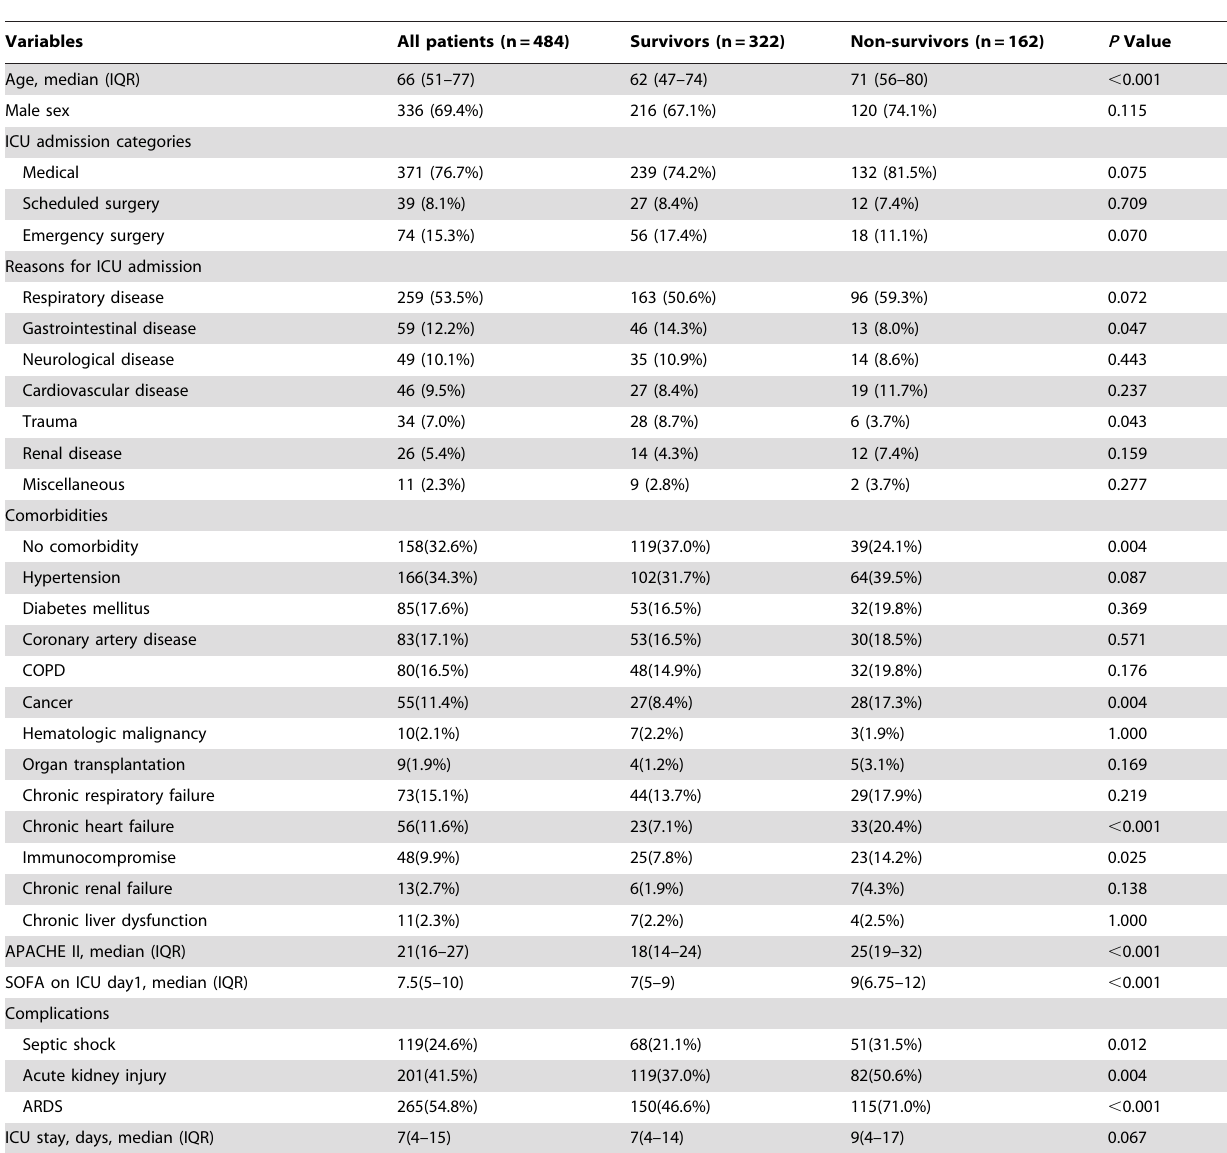
Table 2. Characteristics and outcome of patients with severe